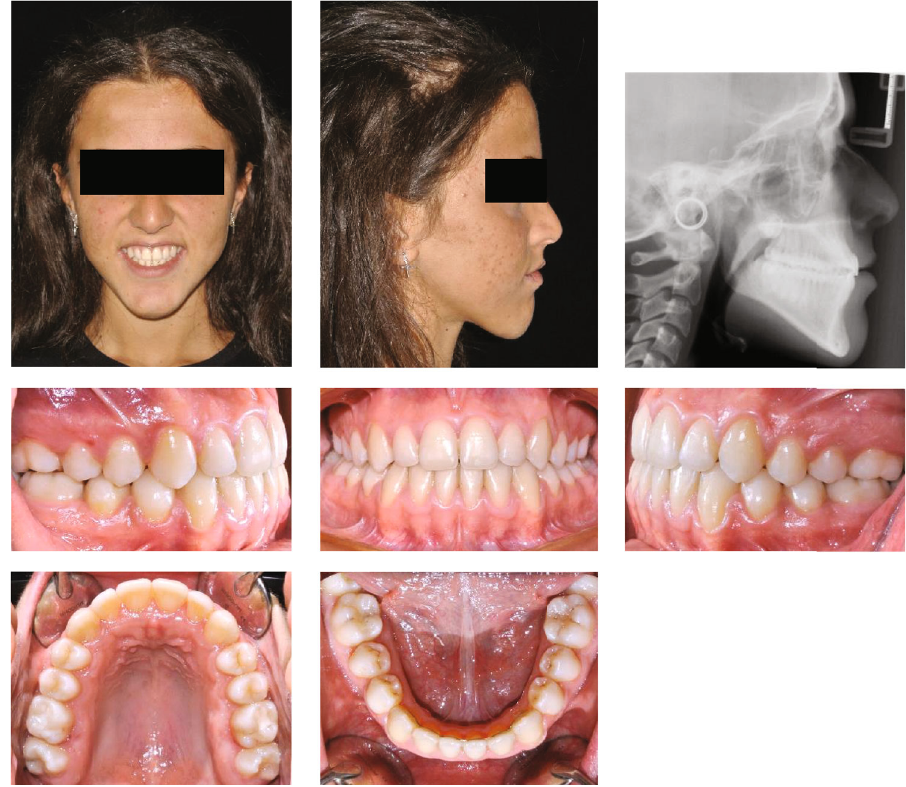
(posttreatment). 2